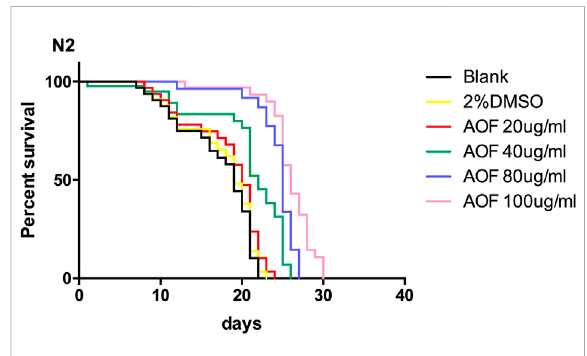
FIGURE 3 Effects of AOF extract concentration on the survival of wild- type C.elegans N2. Data are the mean ± SD ( n =